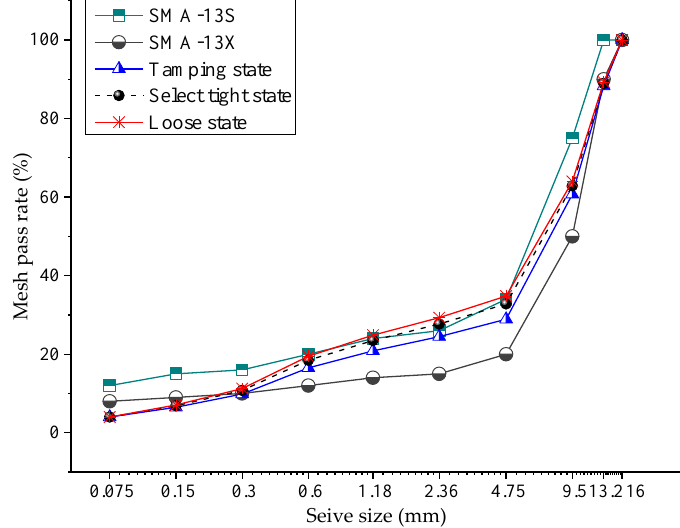
Figure 5. Comparison of test gradation and SMA gradation.